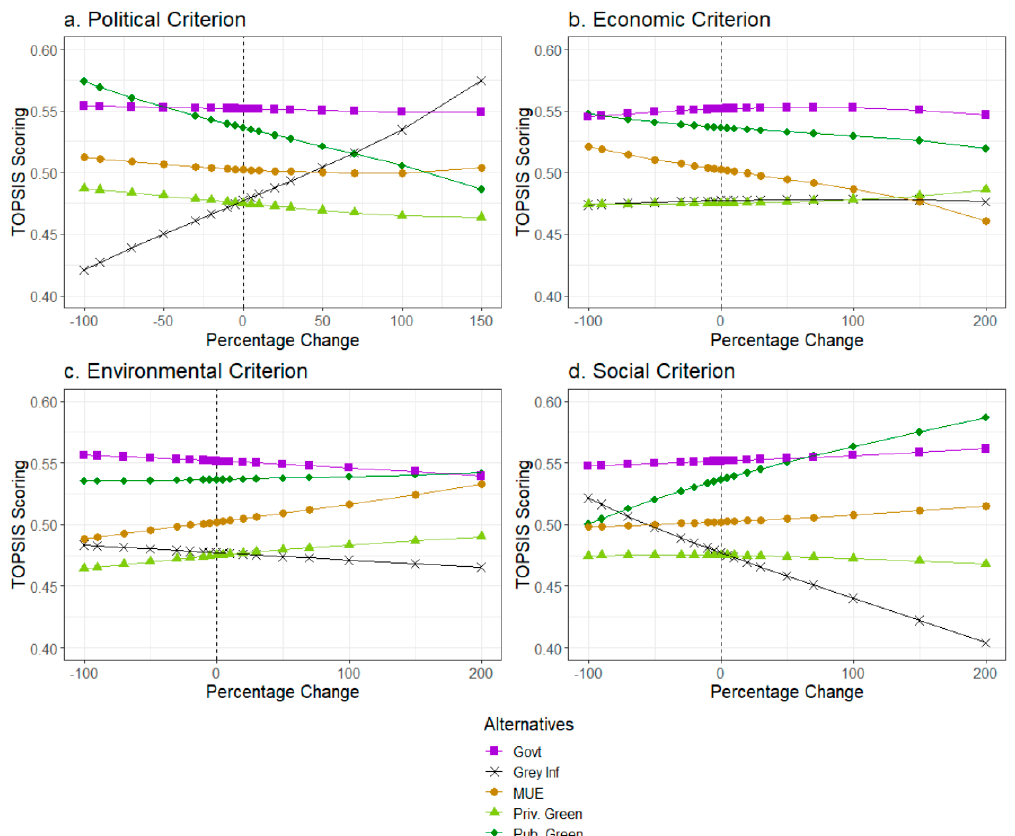
Figure 4. The sensitivity analysis results of shifting the weight of a criterion and the resulting TOPSIS ranking of the alternatives for the ( a ) political, ( b ) economic, ( c ) environmental, and ( d ) social criterion with government streamlining (govt), grey infrastructure overhauls (grey inf), maintaining urban environments (MUE), private green infrastructure (priv. green), and public green infrastructure (pub. green).